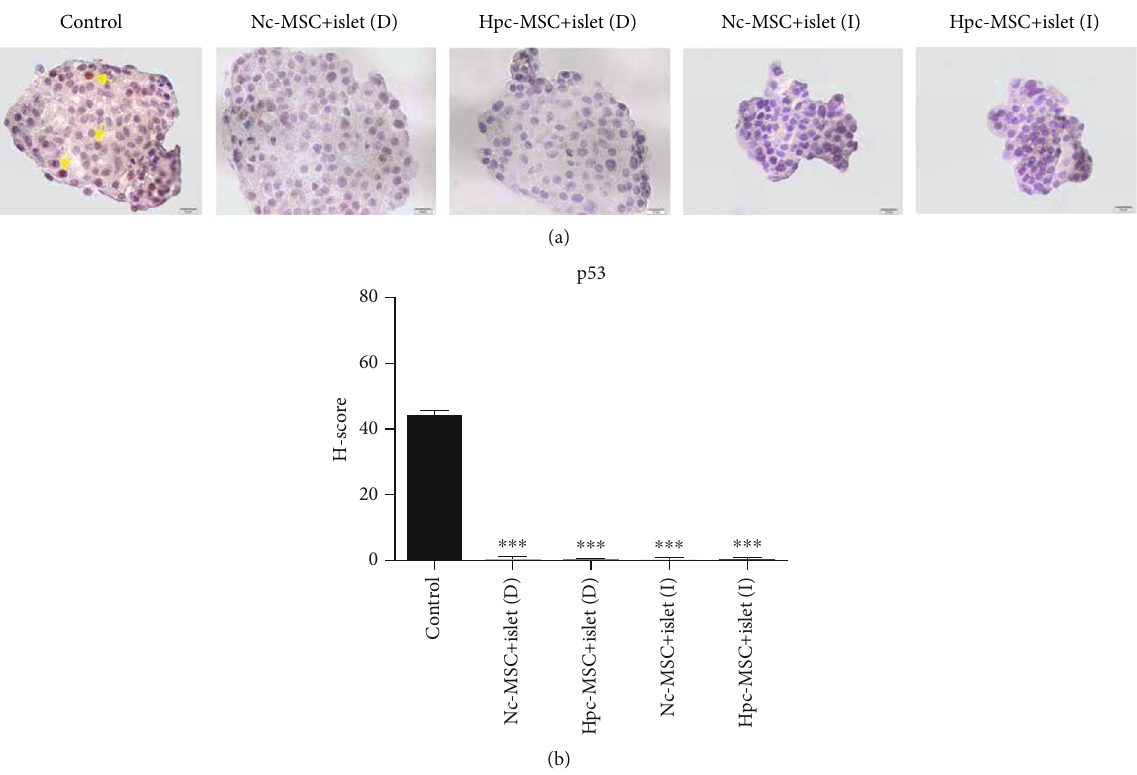
Figure 8: p53 protein level in human islets cocultured with Hpc-MSCs and Nc-MSCs. (a) p53 protein immunocytochemistry. (b) p53 protein level in the islets as graphs based on the H-score method. A comparison was done between the control and each cocultured islets (yellow arrows show positive protein expression). Scale bar: 10 μ m. ∗ P < 0 : 05 , ∗∗ P < 0 : 01 , and ∗∗∗ P < 0 : 001 . Nc-MSCs: normoxia condition